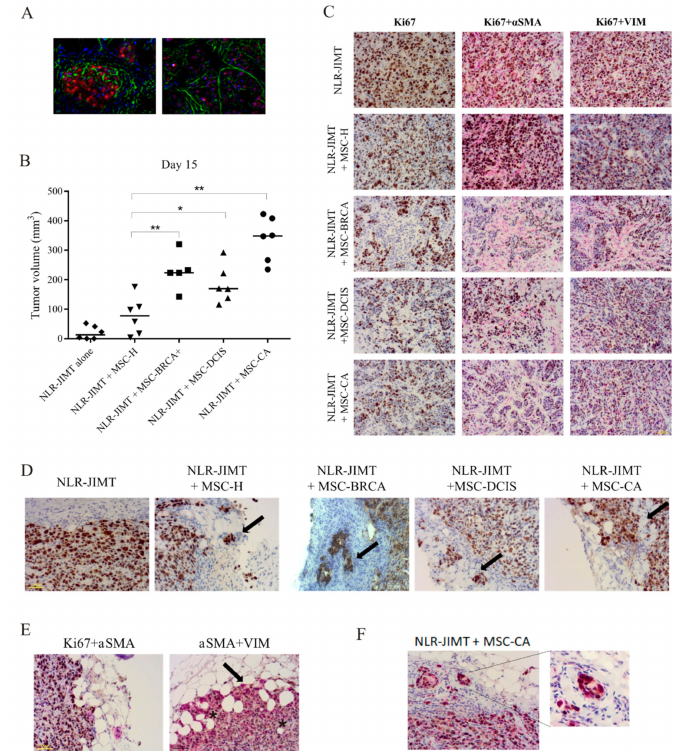
Figure 8. Cancer patient adipose tissue-derived MSCs showed a pro-tumorigenic e ff ect on subcutaneous tumor xenografts in vivo. ( A ) Actin immunofluorescence staining of mice xenograft cryosection shows xenograft composition formed by tumor cells and MSCs (left—xenograft periphery, right—xenograft center; red—cancer cell nuclei, green—actin cytoplasm staining, blue - nuclei staining with DAPI. Magnification 630 × .) ( B ) 5 × 10 5 MSCs of di ff erent origin were subcutaneously co-injected with 1 × 10 6 NLR-JIMT cells in immuno-compromised SCID / Beige mice. Tumor volume examination